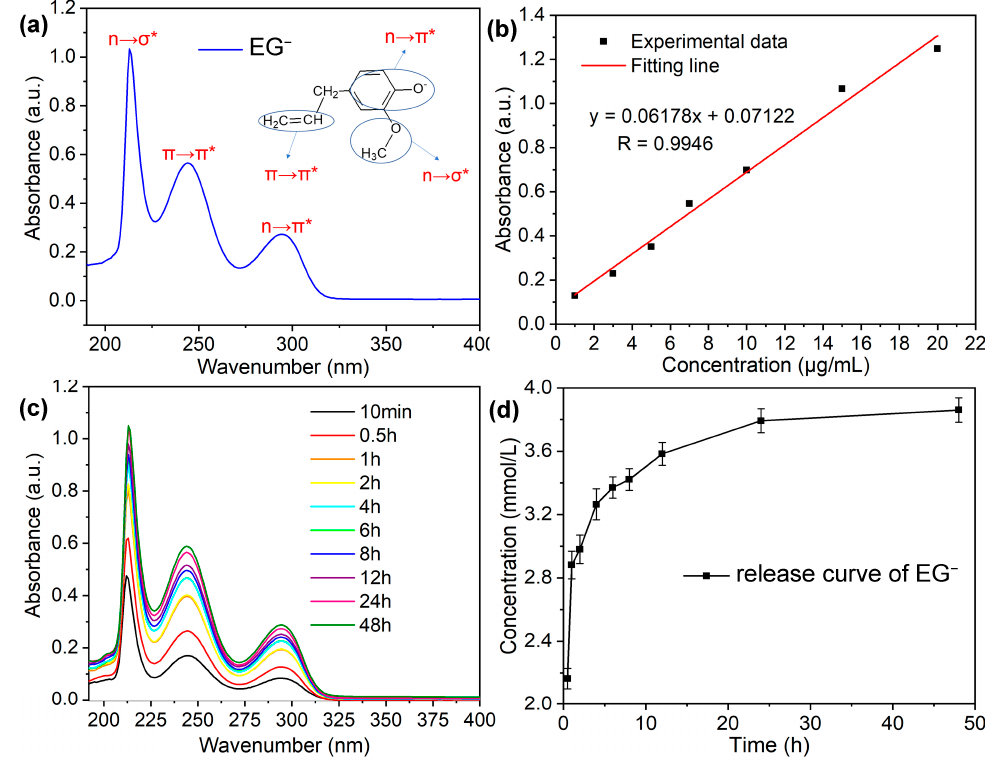
Figure 5. ( a ) UV − vis absorption spectra of pure EG − in SCPs solution containing 3.5 wt.% NaCl; ( b ) The plot of UV − vis calibration curve of pure EG − in SCPs with NaCl solution obtained by using linear fi tt ing method; ( c ) UV − vis absorption spectra of EG − released from LDH into SCPs with NaCl solutions within 48 h; ( d ) EG − release kinetics from LDH − EG − into SCPs with NaCl solutions within 48 h.